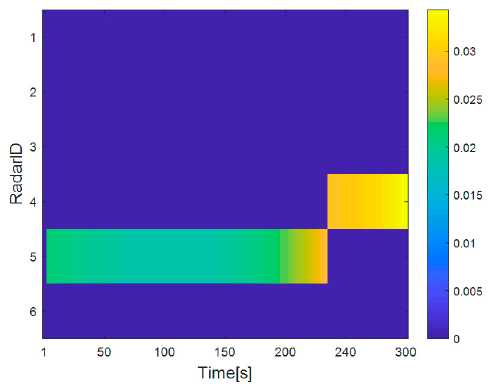
Figure 5. Target 2 dwell time allocation ratio. Table 3. Comparison of total dwell time of radar network.